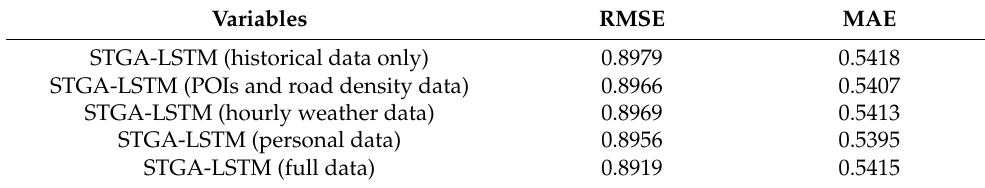
Table 2. Predictive performance of the different exogenous variables.